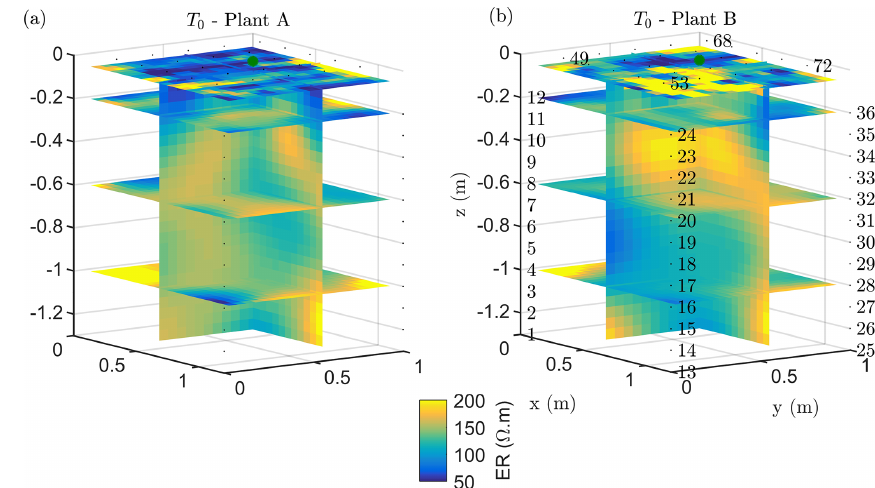
Figure 3. Results of the 3D ERT inversion for the background time T0 for plant A (a) and B (b) . Three-dimensional resistivity volume (log scale) sliced at the tree stem position (vertically) and at four depths (0.05, 0.2 0.6 and 1m), with the green point showing the location of the plant